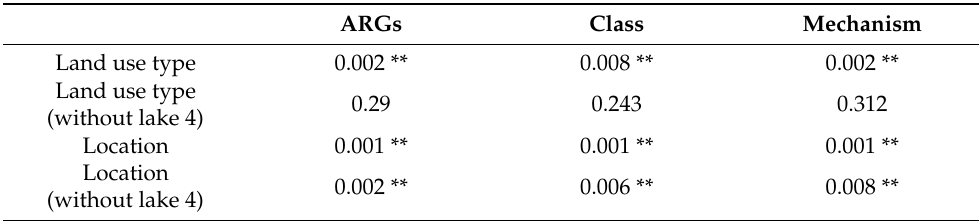
Table 2. P values of a PERMANOVA test between land use types and individual locations for indi- vidual ARGs, class and mechanism composition.